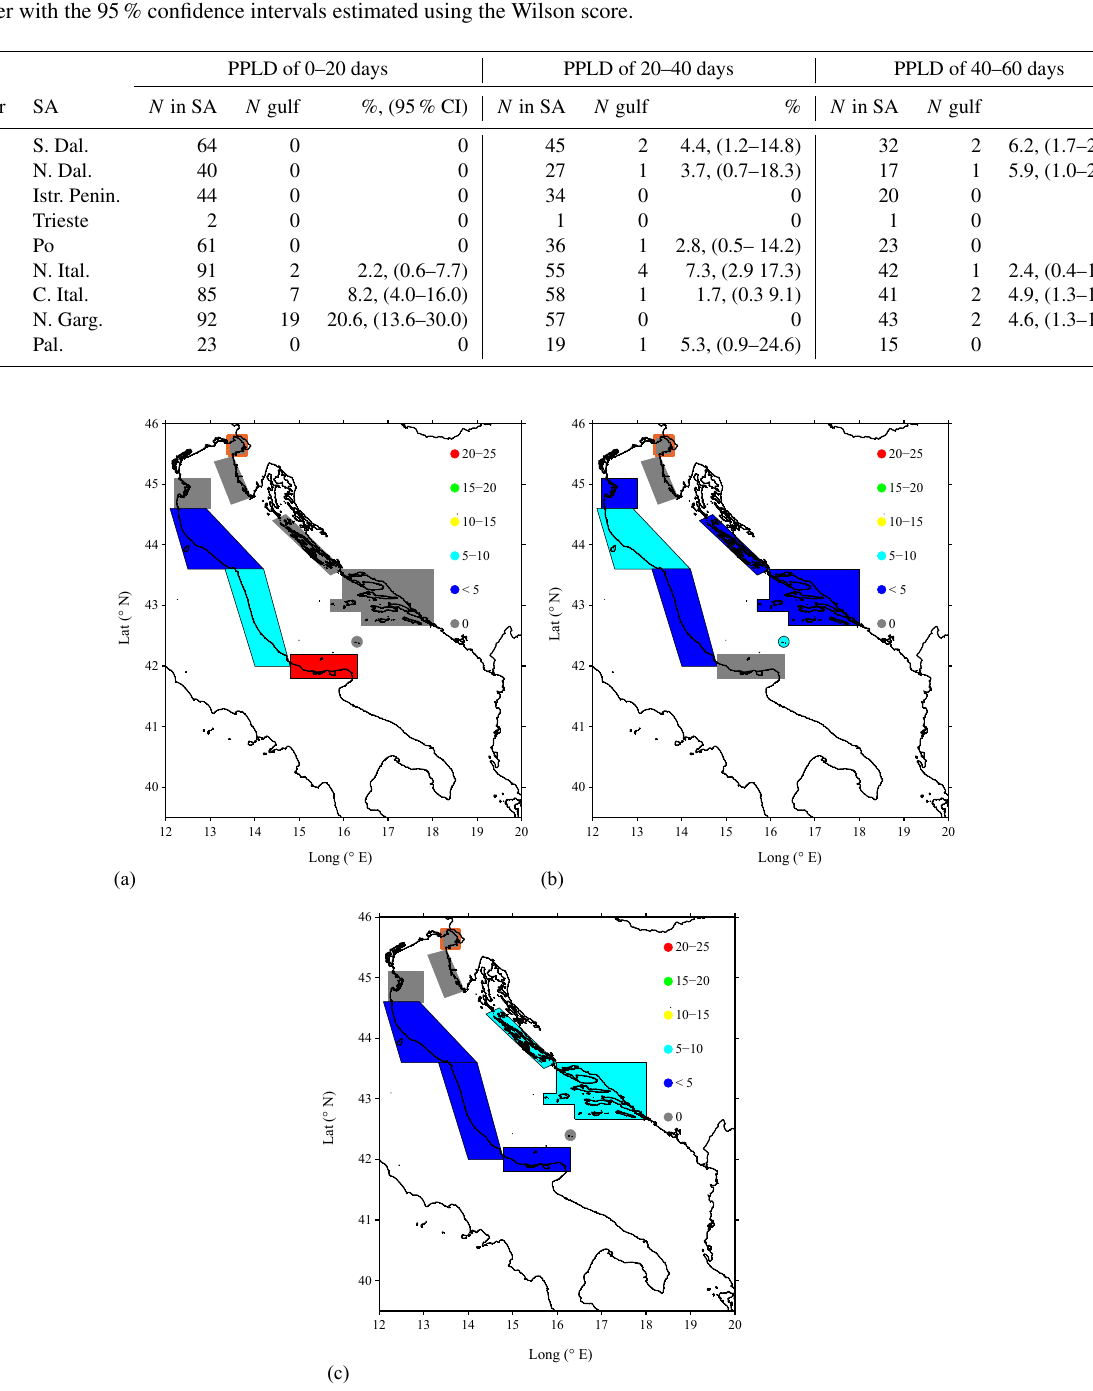
Table 2. As in Table 1 but for drifters during the spawning season (September–May) and for three ranges of PPLD (results shown in Fig. 4). Results are grouped for PPLD ranges, showing for each range the number ( N ) of drifters that entered or were launched in a given SA, the number of drifters that continued from the SA to the Gulf of Manfredonia ( N gulf), and the percentage (%) of N gulf drifters with respect to N , together with the 95% confidence intervals estimated using the Wilson score.